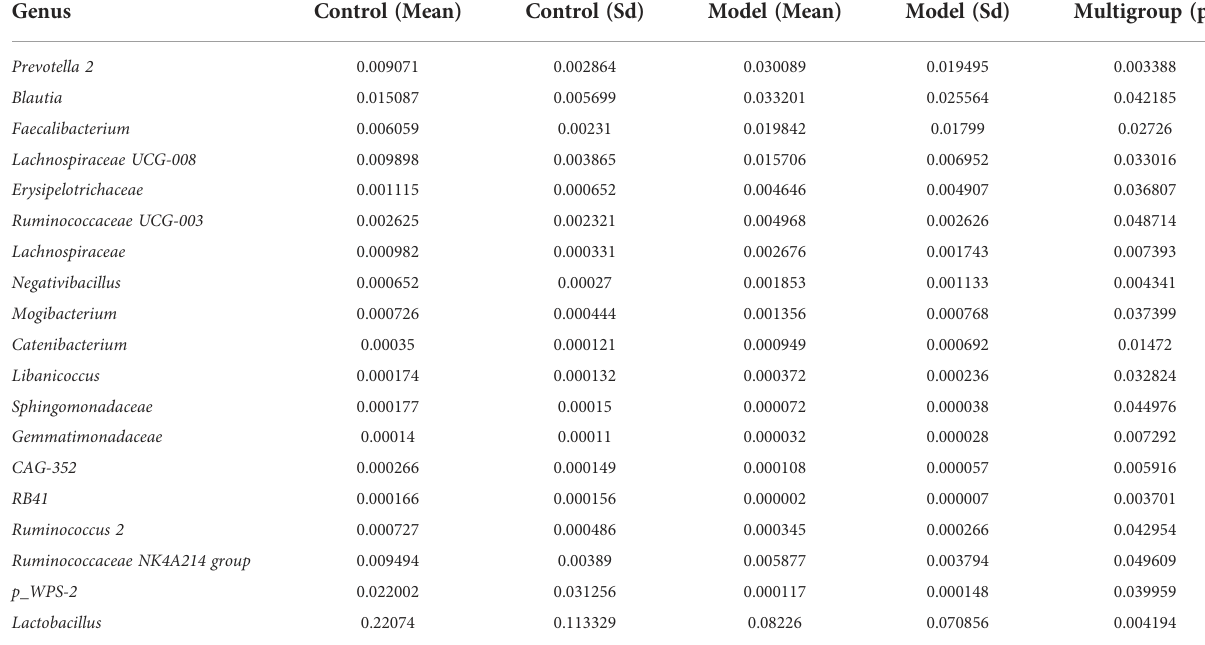
TABLE 5 ANOVA (Analysis of Variance) at genus level of bacterial microbiota of Cynomolgus macaques ( p <0.05). Genus